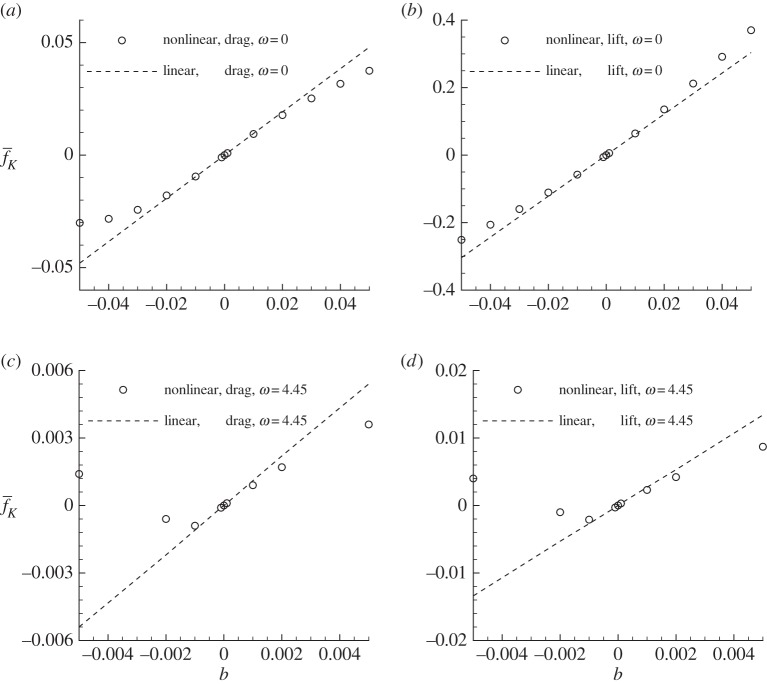
(a–d) Mean control-induced forces from linear and nonlinear calculations at ω=0, α=10° and Re=1000. b is a scale factor, its absolute value is the b-norm of the control and b=0 corresponds to the uncontrolled condition.